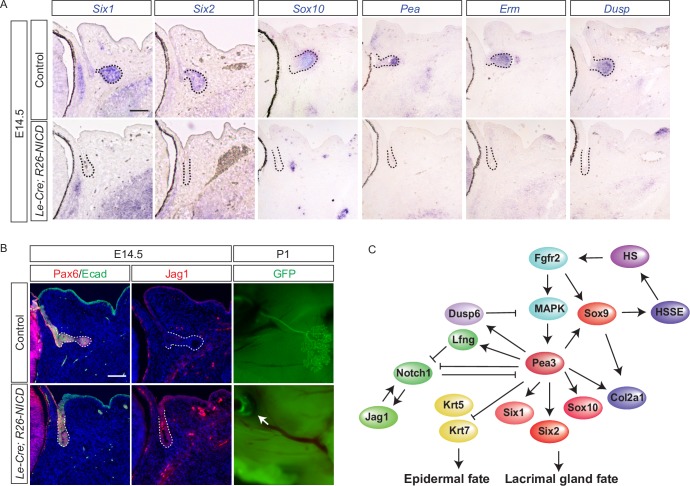
Ectopic activation of Notch signaling abolished lacrimal gland development.(A) Ectopic induction of Notch signaling by Notch-ICD overexpression abrogated many of the Pea3-regulated genes in the lacrimal gland bud (dotted lines). Scale bar, 50μm. (B) Notch-ICD overexpression did not perturb lacrimal gland progenitor cell markers Pax6 and Ecad but resulted in the up regulation of Jag1 expression. At P1, no lacrimal gland was observed (arrow). Scale bar, 50μm. (C) Schematic diagram of the Pea3-regulated genetic network in lacrimal gland development.